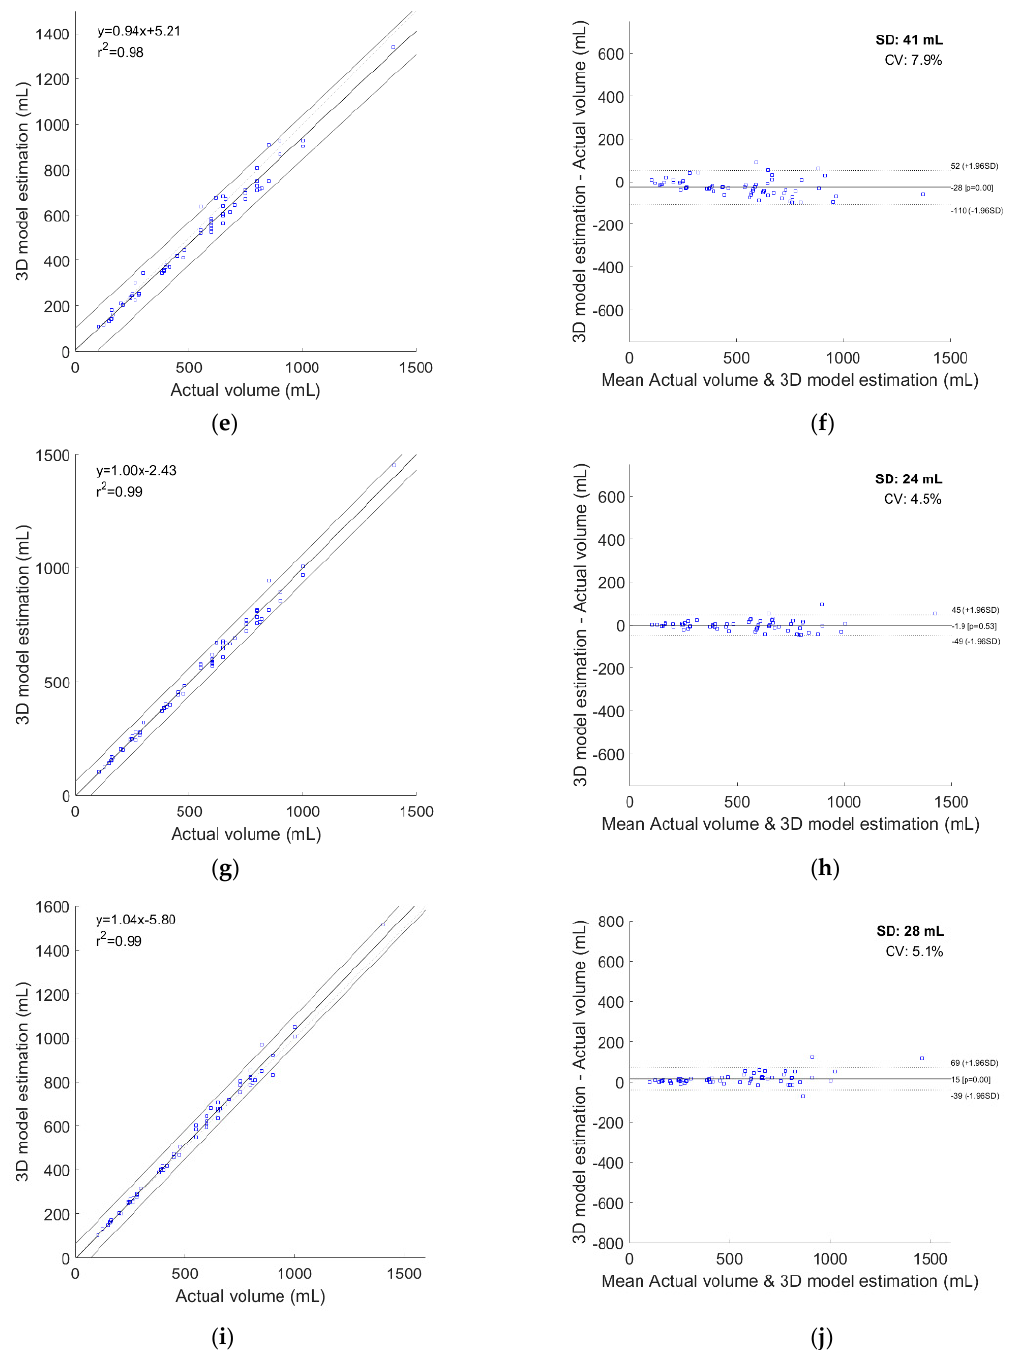
Figure 6. Traditional and 3D reconstruction model estimation result. ( a ) Correlation with 95% confidence interval and linear regression equation in Traditional estimation. ( b ) Difference in the Bland–Altman plot with 95% confidence interval in Traditional estimation. ( c ) Correlation with 95% confidence interval and linear regression equation in 3D reconstruction of N = 2 model. ( d ) Difference in the Bland–Altman plot with 95% confidence interval in 3D reconstruction of N = 2 model. ( e ) Correlation with 95% confidence interval and linear regression equation in 3D reconstruction of N = 3 model. ( f ) Difference in the Bland–Altman plot with 95% confidence interval in 3D reconstruction of N = 3 model. ( g ) Correlation with 95% confidence interval and linear regression equation in 3D reconstruction of N = 4 model. ( h ) Difference in the Bland–Altman plot with 95% confidence interval in 3D reconstruction of N = 4 model. ( i ) Correlation with 95% confidence interval and linear regression equation in 3D reconstruction of N = 5 model. ( j ) Difference in the Bland–Altman plot with 95% confidence interval in 3D reconstruction of N = 5 model. SD: standard deviation; CV: coefficient of variation.